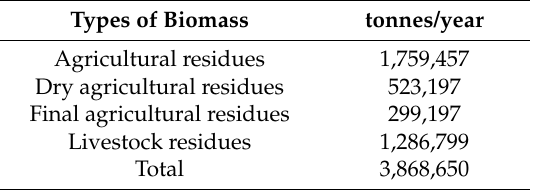
Table 5. Quantities of recoverable biomass in the regional unit of Thessaly [65,66].